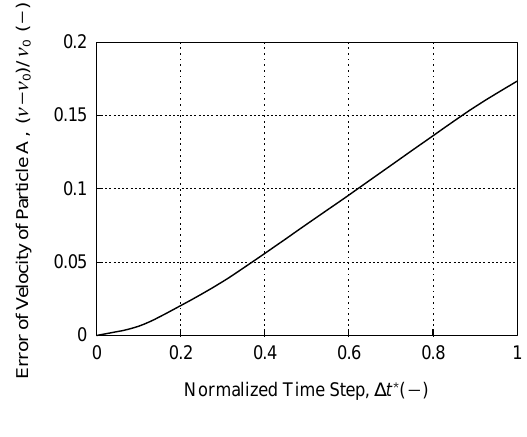
Error of velocity of particle A